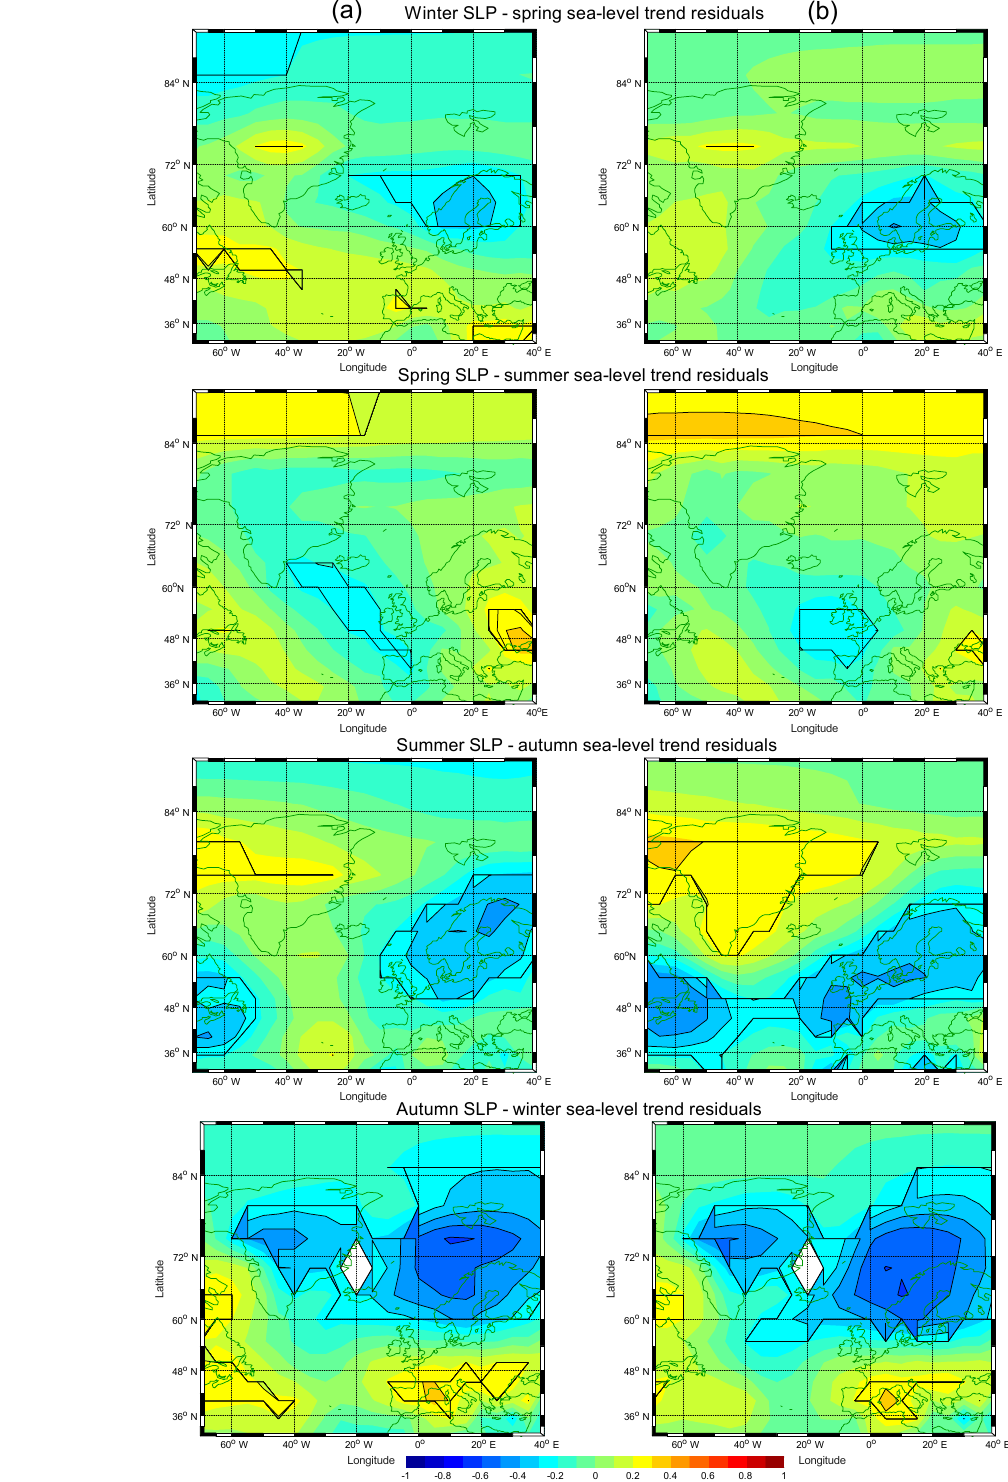
Figure 9. The correlation patterns between decadal gliding trends of the sea-level residuals and decadal SLP trends in the previous season. Panels (a) and (b) show the results of Stockholm (Warnemünde) station. The areas indicating significant correlations are delineated with contour lines. The 95% significance level is ± 0.19 for this record